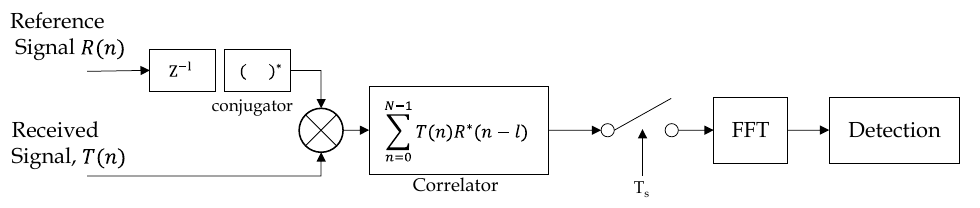
Figure 9. Signal processing chain.